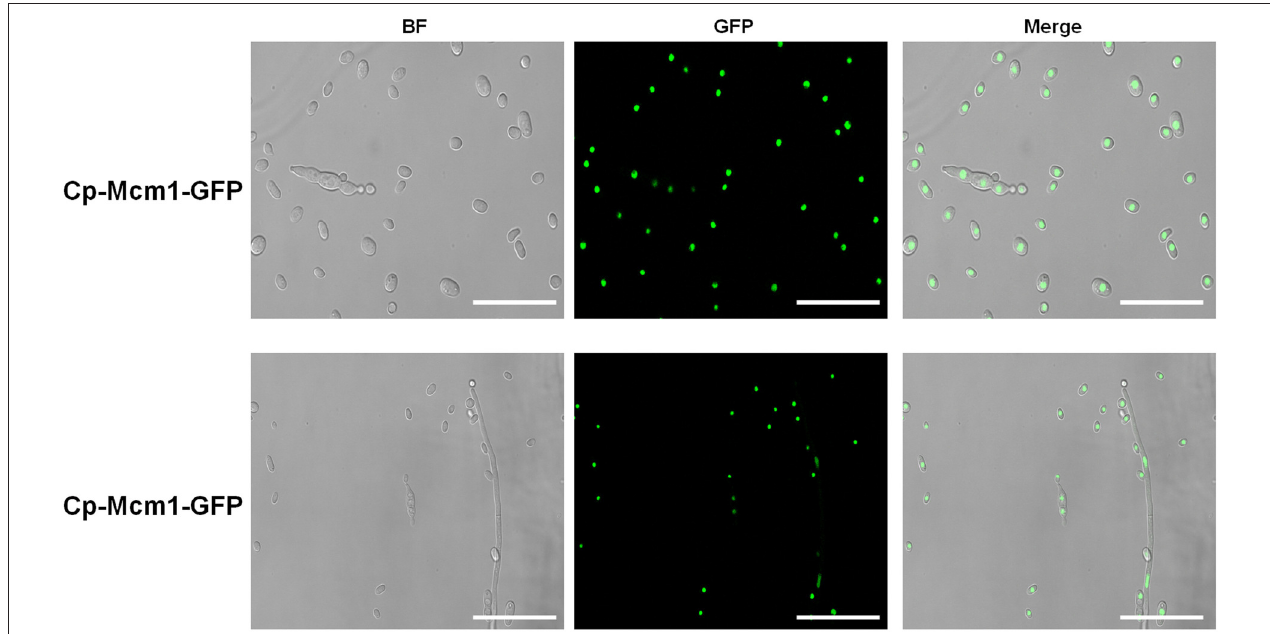
FIGURE 8 | Subcellular localization of VdMcm1. Confocal microscopy of Cp-Mcm1 - GFP ( VdMcm1-GFP fusion, containing native promoter and coding sequence of VdMcm1 without stop codon and GFP fragment, was introduced into the VdMcm1 deletion mutant) conidia and hyphae, which were harvested from liquid CM. The fluorescence was mainly localized in the nucleus. The scale bars represent 25 µ m.